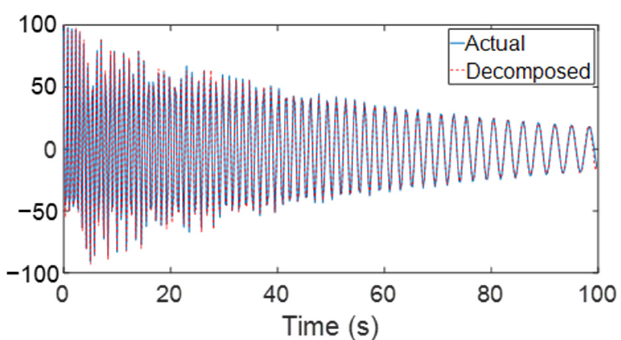
Figure 6. Comparison between actual and decomposed system responses.